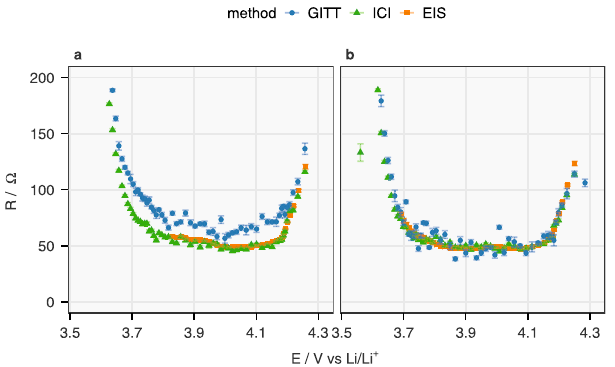
Fig. 6 | Comparison between the internalresistance derivedfromthe GITT, ICI method and EIS. The internal resistance ( R ) of NMC811 in Cell 1 at various OCP of the electrode ( E ) derived from the GITT with data selection interval 5 – 40s, the ICI method and the EIS fi tting (R0+R1+R2 in the equivalent circuit model in Sup- plementary Fig. 13) during charging and discharging are plotted in a , b , respec- tively. The maximum of y -axis is set to 200 Ω to show the differences of the data above 3.7V. The error bars originate from the standard deviation of the linear regression.